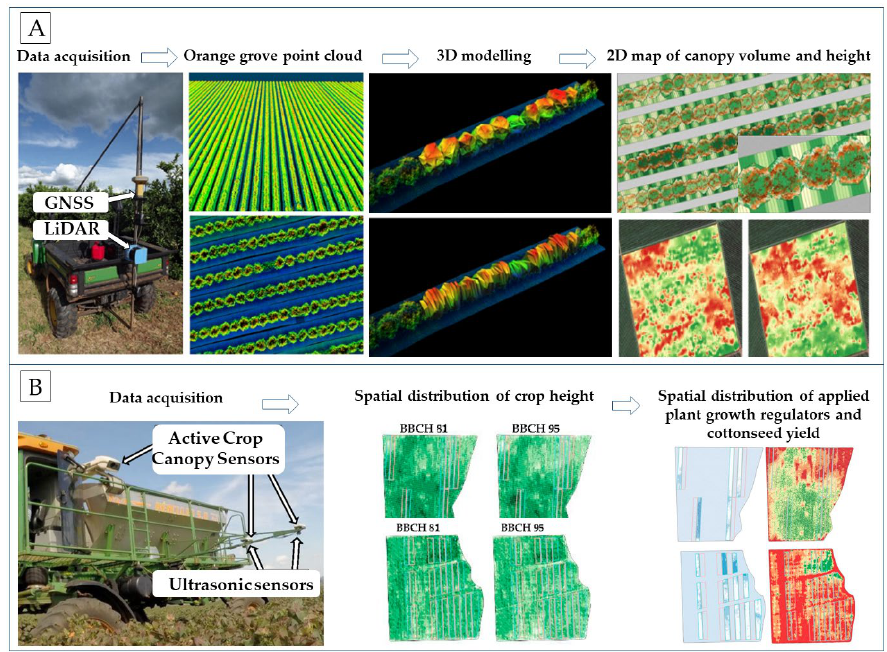
Figure 8. Advances in modeling crop canopy in Brazil: ( A ) Orange crop geometry information using a mobile terrestrial laser scanner and 3D modeling (adapted from Colaço et al. [90]); ( B ) management of plant growth regulators in cotton using active crop canopy sensors (adapted from Trevisan et al. [94]).